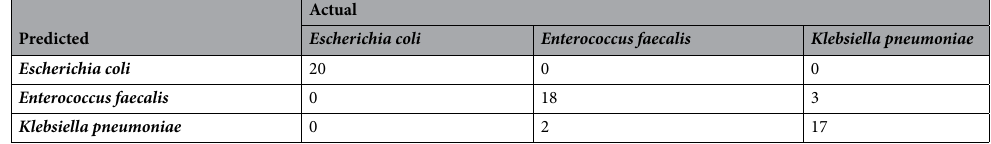
Table 4. Bacterial classification in infected urine samples (achieved using PC-LDA). Accuracy 91.6% (95% CI: 81.6–97.2%; p -value < 0.05), Cohen’s K = 0.88.